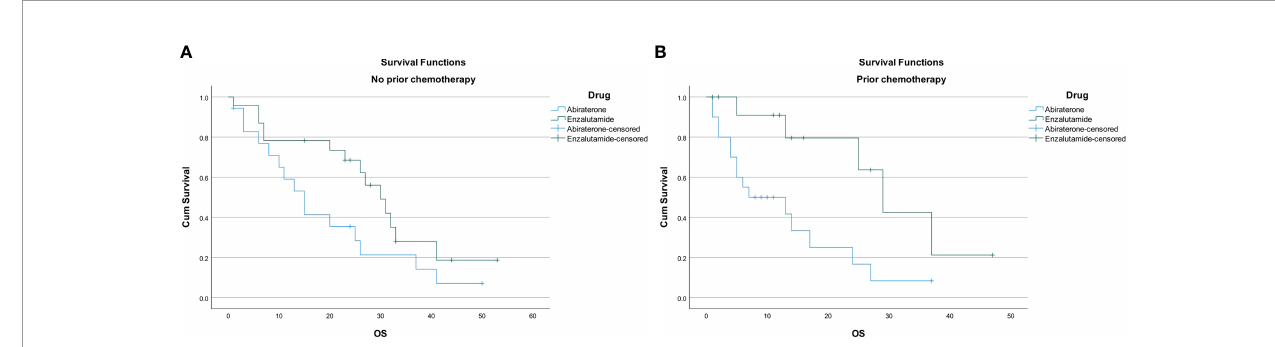
FIGURE 3 | (A) Overall survival in chemotherapy naive patients. (B) Overall survival in patients with prior chemotherapy